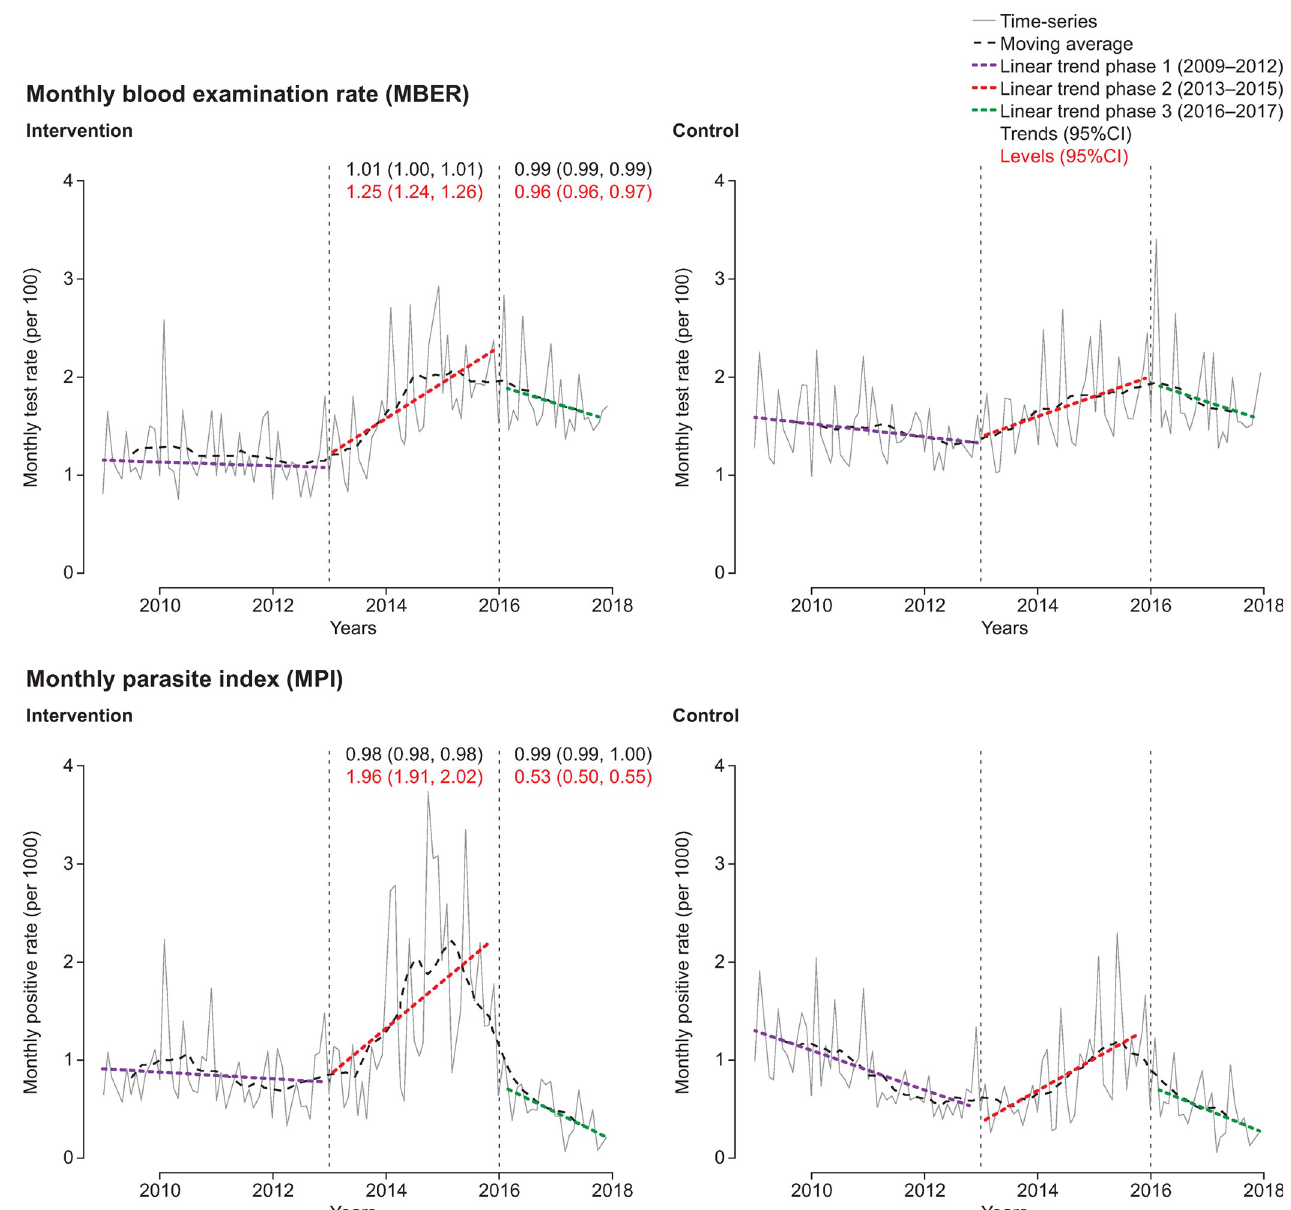
Fig 3. Interrupted time-series analysis of changes in malaria indices for pooled data. MBER, monthly blood examination rate = total number of slides examined in a month x1000 / total population; MPI, monthly parasite index = total number of positive slides for parasite in a month x1000 / total population.